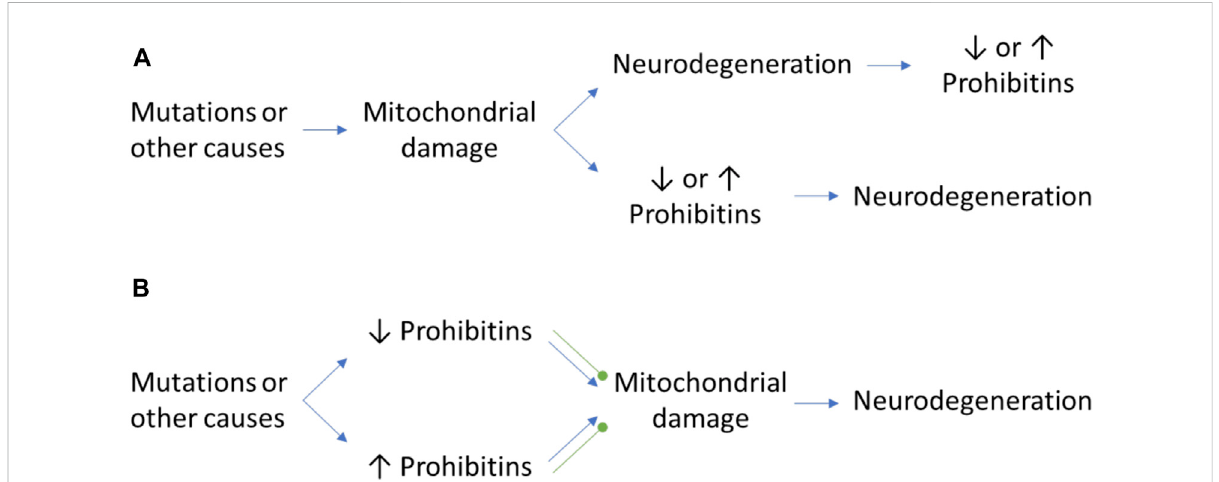
FIGURE 1 The controversial role of PHB in neurodegeneration. (A) Mitochondrial damage may cause neurodegeneration and a differential expression of PHB as a consequence of the neurodegenerative process or the activation of mitophagy pathways. Inversely, the mitochondrial damage itself may cause an alteration of PHB expression levels which may trigger the neurodegenerative process. (B) The alteration of PHB levels in normal conditions due to mutations in other proteins may have bene fi cial and detrimental effects that will cause the protection against mitochondrial damage or the promotion of it, respectively. Green round arrows: protection against mitochondrial damage, which prevents